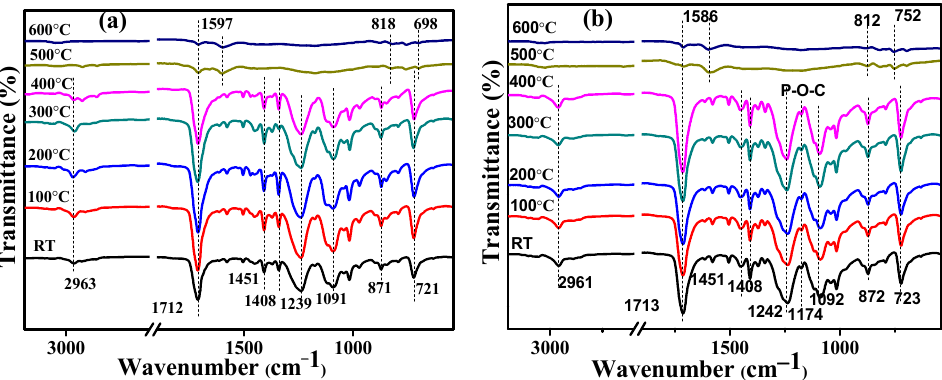
Figure 8. Real-time Fourier transform infrared spectroscopy (RTFTIR) spectra for condensed products of ( a ) PET ( b ) PET-0.4G-0.2H.